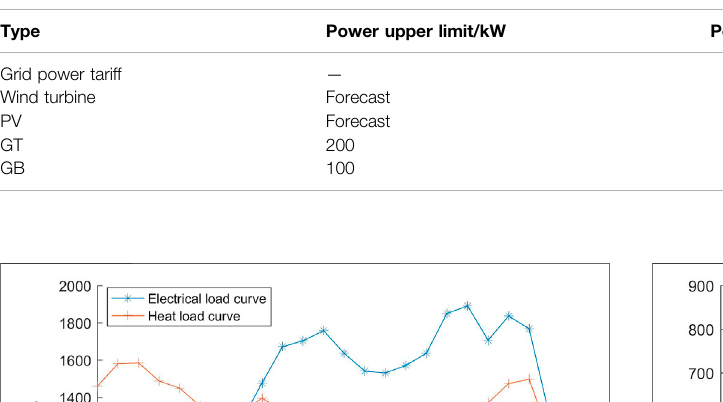
TABLE 1 | Park IES operating parameters.